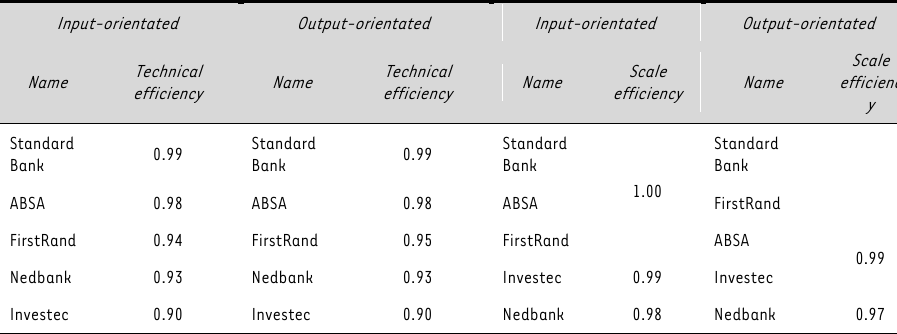
Summary of the average efficiency results